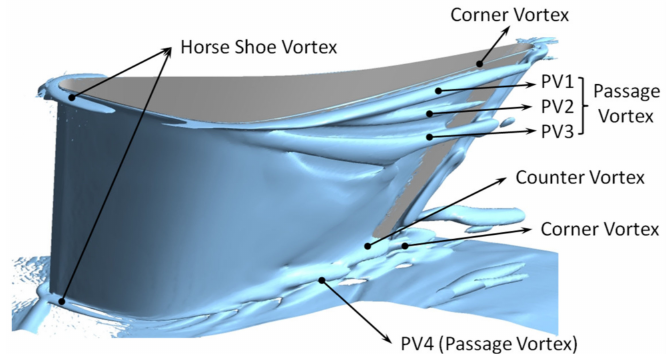
Figure 15. Vortices in the integrated LPT-GV passage when d / s =